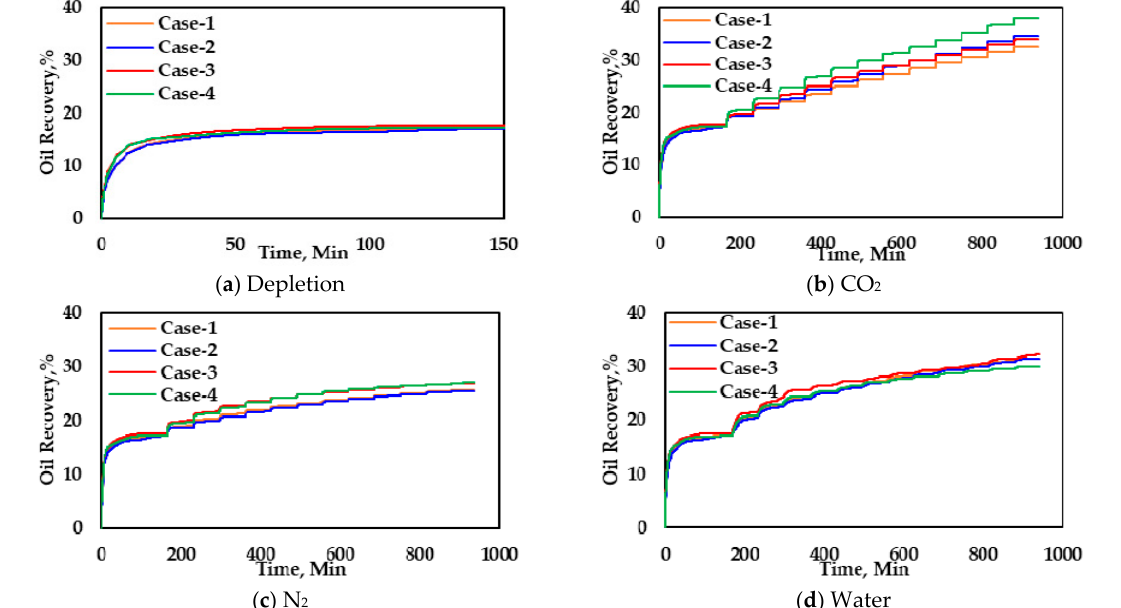
Figure 26. Oil recovery comparison between different scattered fractures.